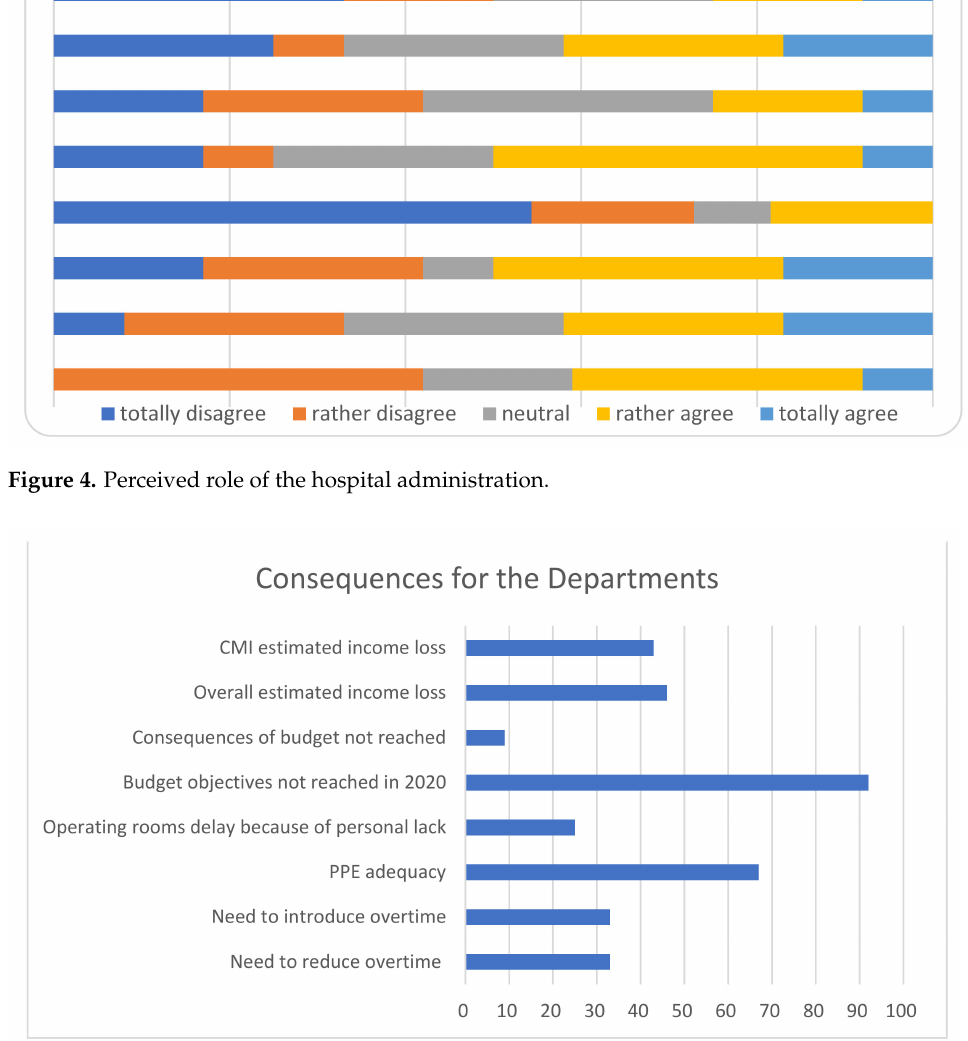
Figure 5. Consequences for the departments. CMI, Case Mix Index; it refers to the estimated income loss, according to the CMI. Each case is weighted, depending on its complexity, according to the diagnosis related group (DRG) [12,13]. PPE, Personal Protective